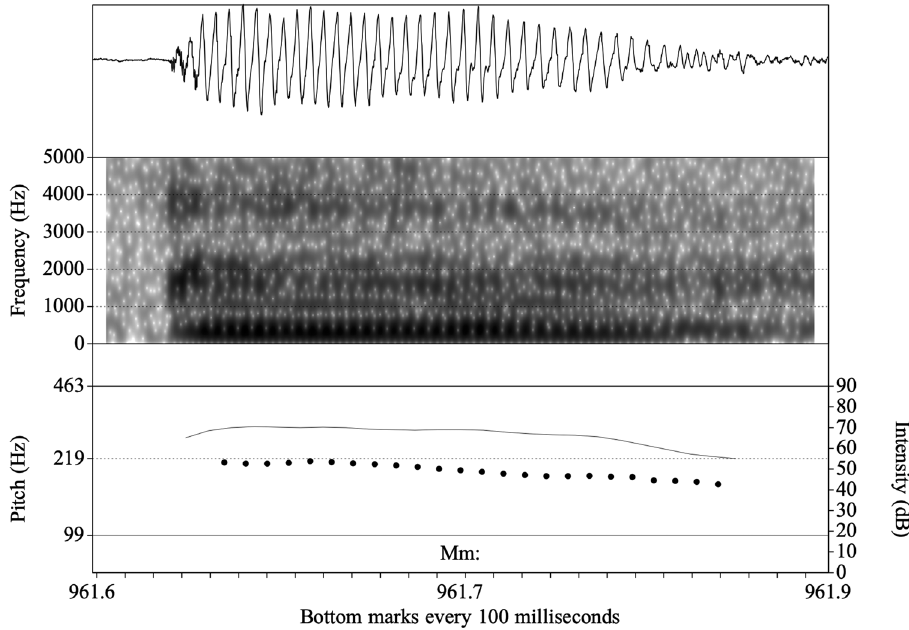
Figure 2: Waveform ( upper panel ) , spectrogram ( middle ) , and F0/intensity trace of L ’ s “ mm ” ( Example 1 line 16 ) . F0 trace scaled to L ’ s minimum/maximum F0, median marked at 219